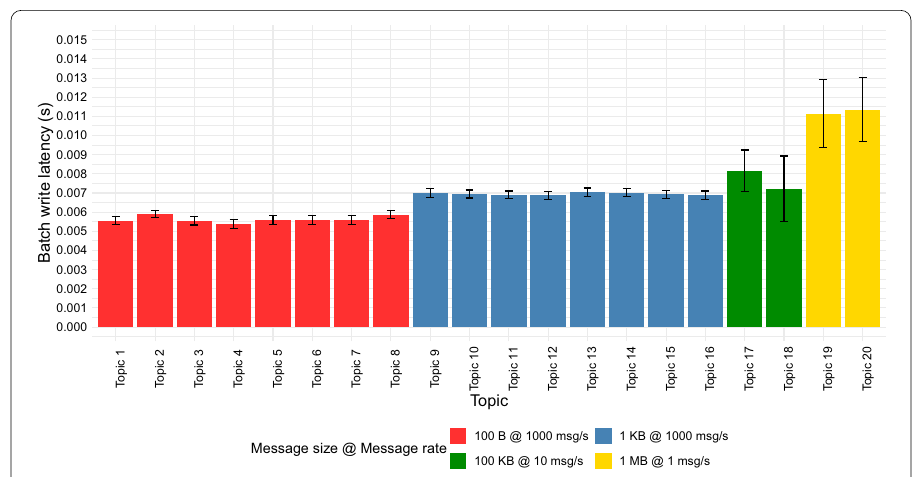
Fig. 5 Batch write latency distribution in a network deployment with 20